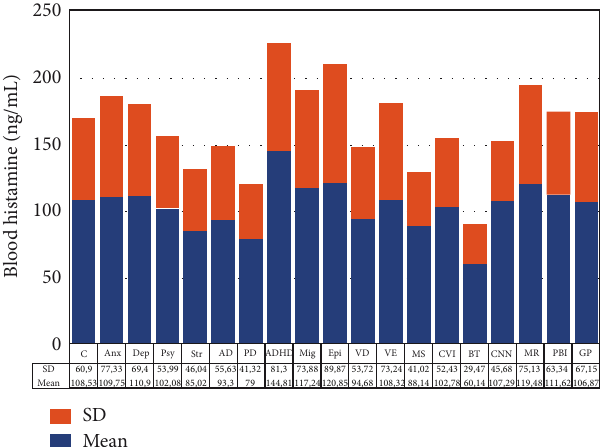
Figure 2: Blood histamine levels in CNS disorders. C: control; Anx: anxiety; Dep: depression; Psy: psychosis; Str: stroke; AD: Alzheimer’s disease; PD: Parkinson’s disease; ADHD: attention- deficit hyperactivity disorder; Mig: migraine; Epi: epilepsy; VD: vascular dementia; VE: vascular encephalopathy; MS: multiple sclerosis; CVI: cerebrovascular insufficiency; BT: brain tumors; CNN: cranial nerve neuropathy; MR: mental retardation; PBI: posttraumatic brain injury; GP: general